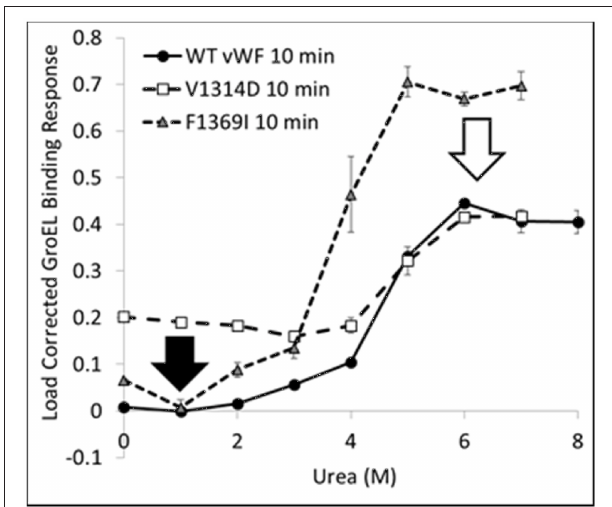
FIGURE 4 | vWF Kinetically Controlled Denaturant Pulse Isotherms for Wild- and Mutant-Types. Kinetic denaturation isotherms for the wild-type (circles), gain of function mutant (squares), and loss of function mutant (triangle) overlaid for comparison. The closed and open arrows denote the potential corrective ligand induced responses that may restore wild-type denaturant pulse profile and protein